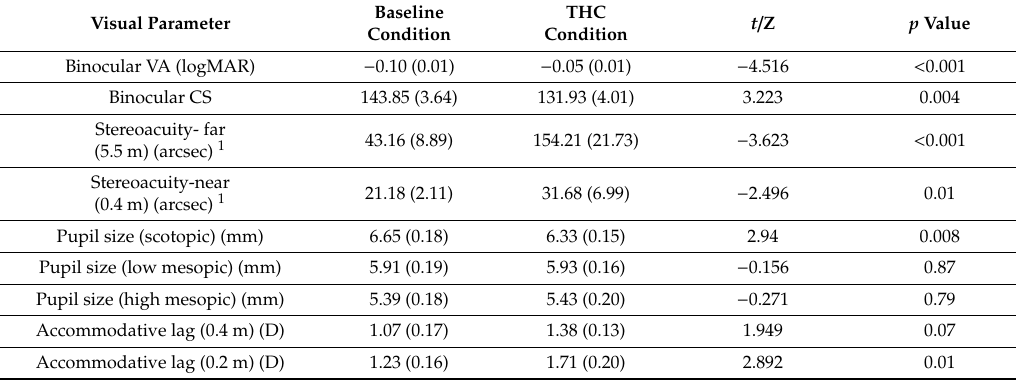
Table 2. Comparison of visual parameters in the baseline session and after smoking